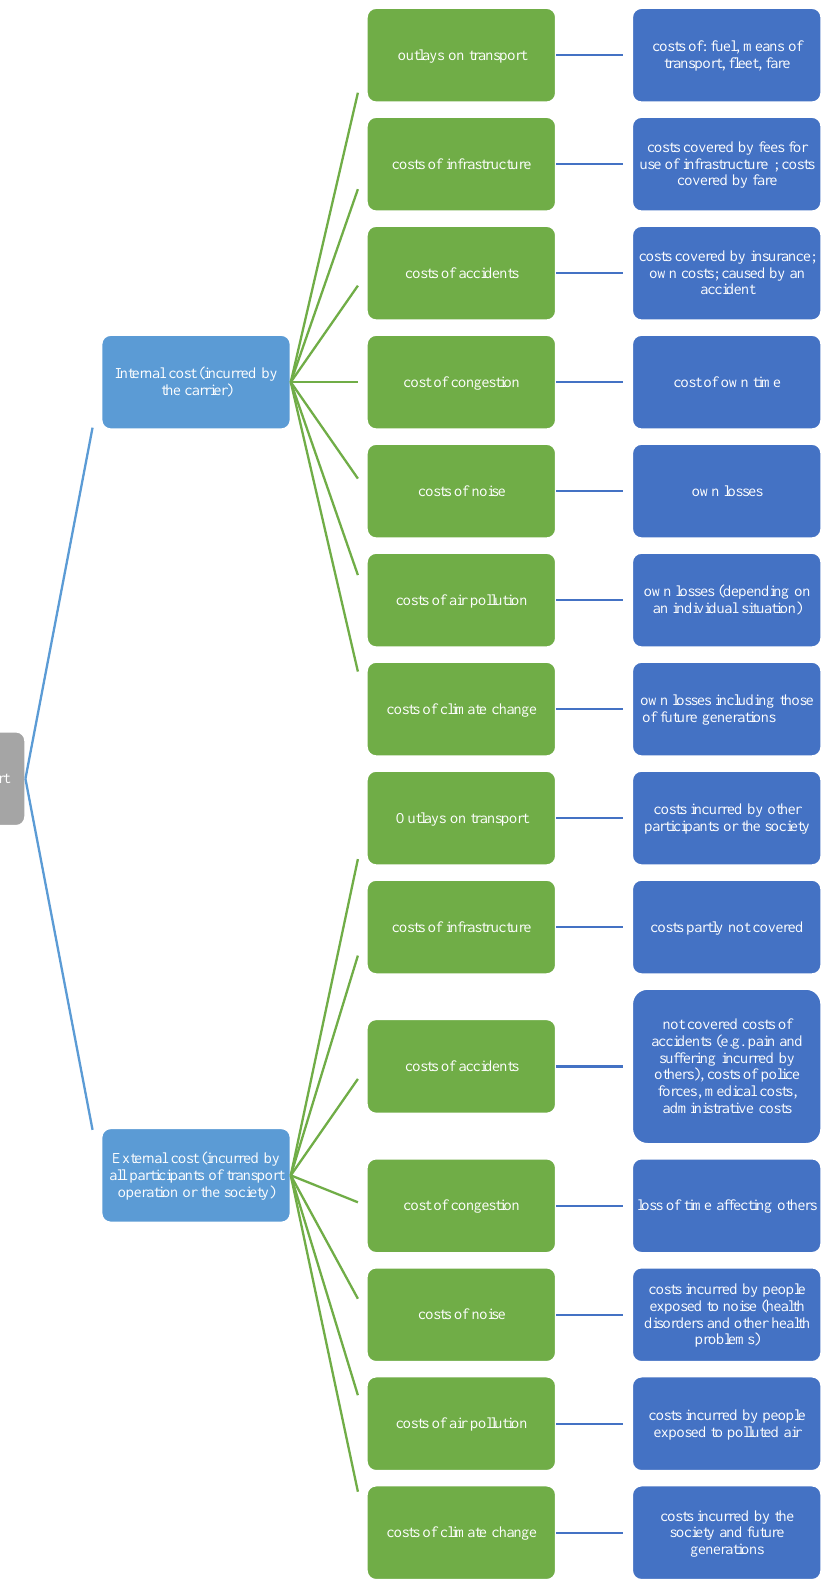
Figure 3. Classification of transport costs. Source: own study based on